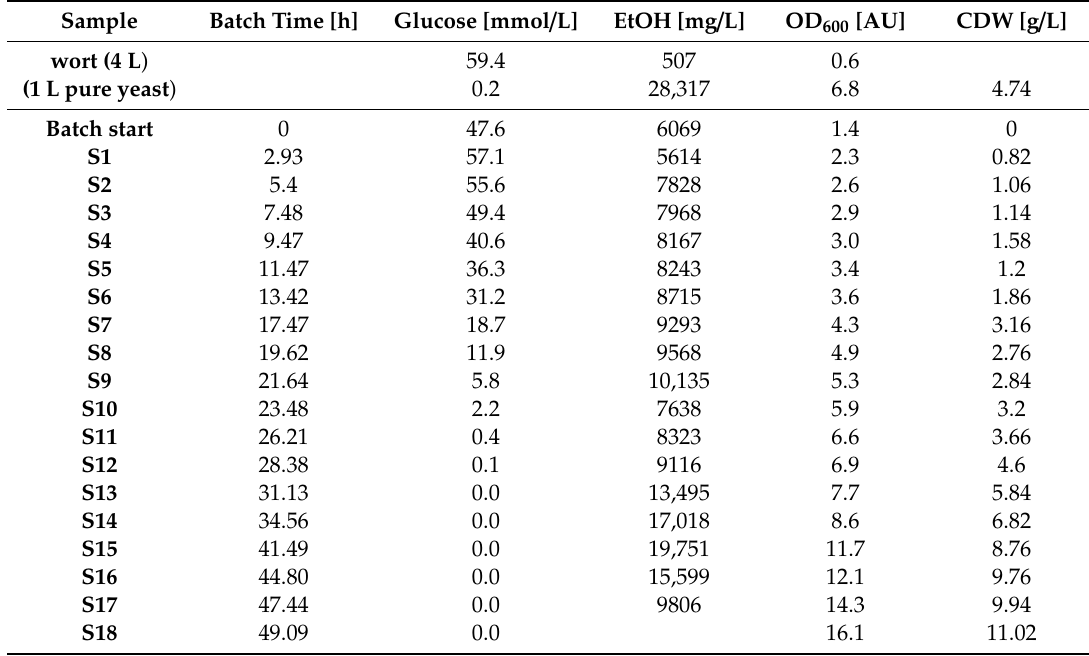
Table 1. Process analytics of the lab-scale propagation, including sugar/ethanol data and biomass related quantities (OD 600 and cell dry weight [CDW]).